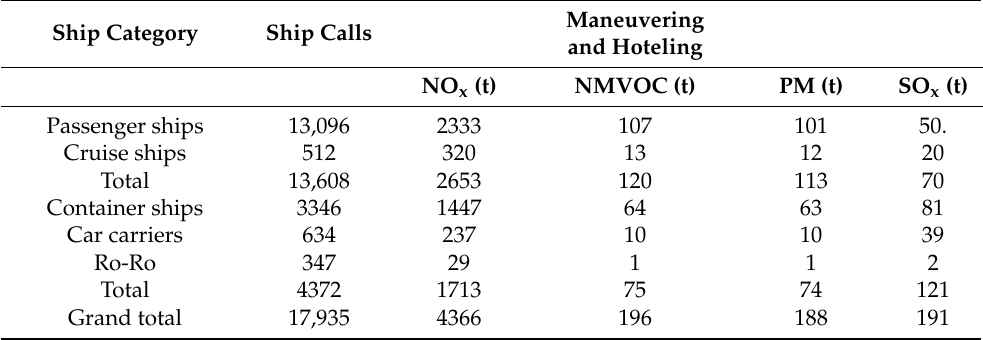
Figure 11. NO x emissions over the port of Bari. Highest values are colored in blue. Adapted with permission from ref. [45]. Copyright © 2019 Elsevier Ltd. All rights reserved. Table 2. Shipping emissions for ship categories and hoteling/maneuvering. Reprinted with permis- sion from ref. [46]. Copyright © 2020 Elsevier Ltd. All rights